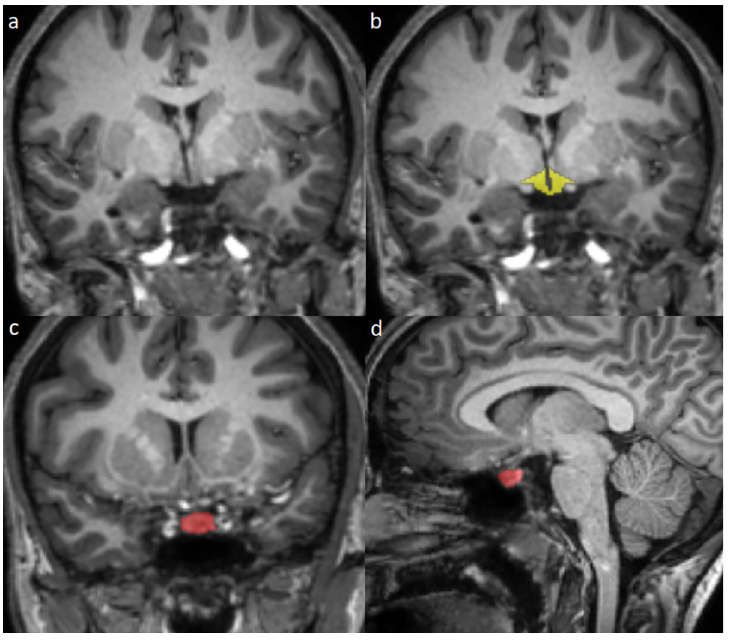
Fig 2. Noncontrast T1-weighted MR images of the hypothalamus and pituitary gland. The hypothalamus is shown without ( a ) and with superimposed segmentation in yellow ( b ). Segmentation of the pituitary gland (red) is shown in the coronal ( c ) and sagittal ( d )